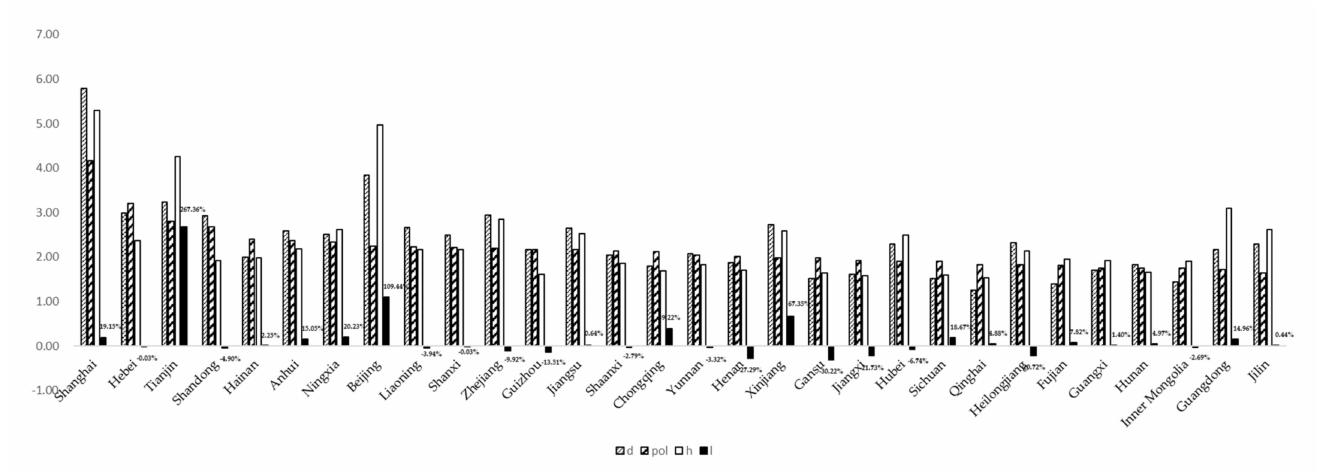
Figure 5. The changes of key variables in 30 provinces in recent years (average value in recent three years). Note: Because the labor mobility index is generally low, numerical labels have been added to show the results clearly; others have not been added.